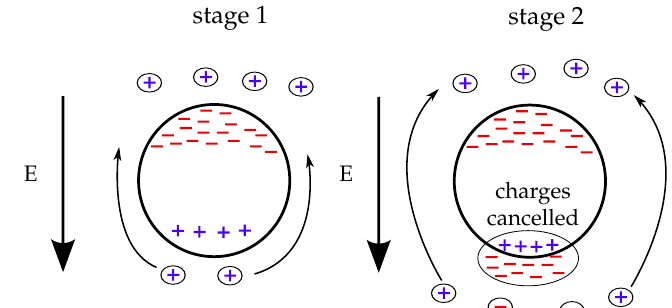
Figure 1. Separation of charges in a thundercloud. Reproduced/Adapted with permission from [3],